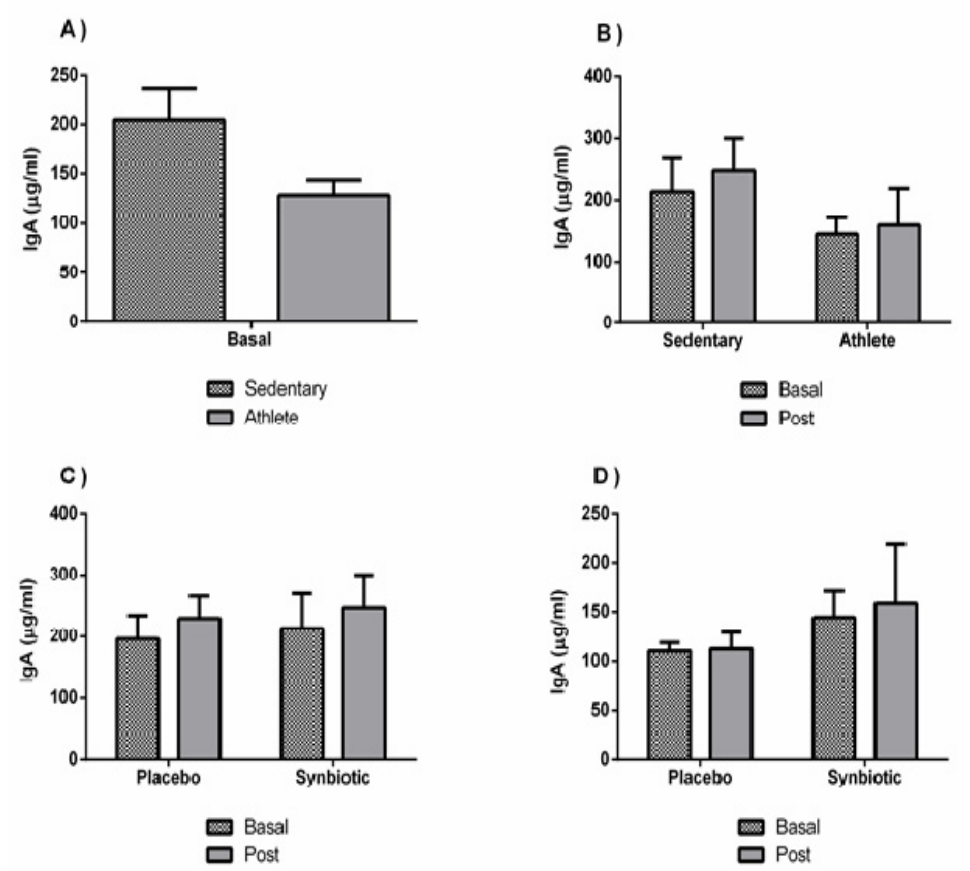
Figure 7. Effect of training and consumption of a synbiotic in this condition on immunoglobulin A (IgA) levels. ( A ) Basal saliva concentrations of IgA in sedentary men ( n = 14) and athletes ( n = 13); ( B ) Influence of training on the effects of the synbiotic on the saliva concentration of IgA ( n = 7 and n = 6 in sedentary and athlete groups, respectively); ( C ) Effect of the consumption of the synbiotic on IgA in sedentary individuals with respect to placebo ( n = 7) or with synbiotic ( n = 7); ( D ) Effect of the consumption of the synbiotic on IgA in athlete individuals with placebo ( n = 6) or with synbiotic ( n = 7). The determinations are expressed by the mean ± SD of each of the samples.